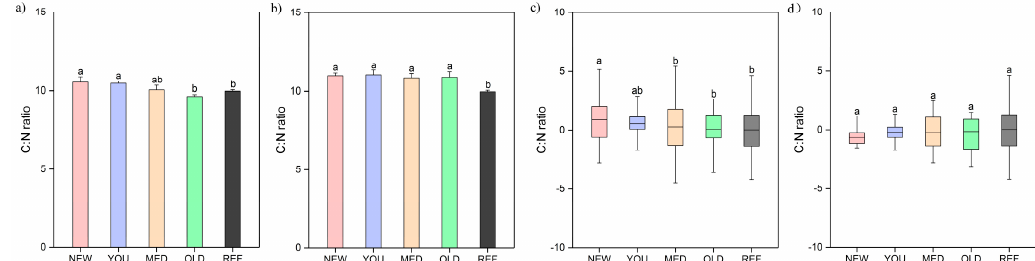
Figure 7. Impact of reclamation ages on soil C:N ratio: ( a ) Values in 2015 assarted from grassland, ( b ) values in 2015 assarted from forest, ( c ) Changes assarted from grassland, ( d ) Changes assarted from forest. NEW = newly assarted (1–5 years), YOU = young assarted (6–15 years), MED = medium assarted (16–25 years), OLD = old assarted (26–37 years), REF = referenced cropland assarted before 1978.